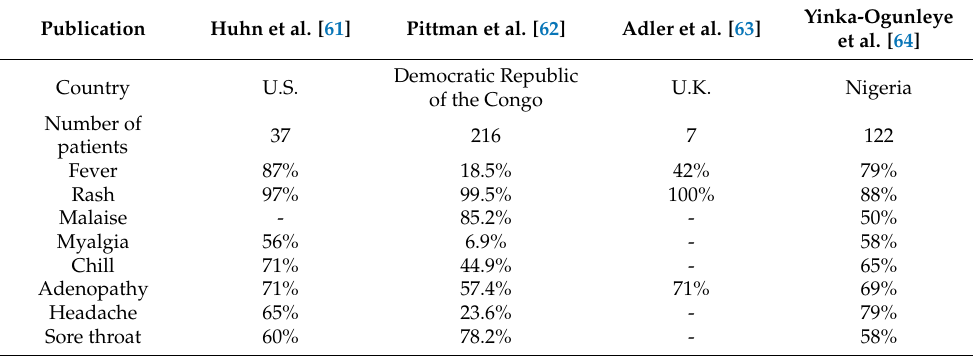
Table 1. Clinical symptoms reported in monkeypox